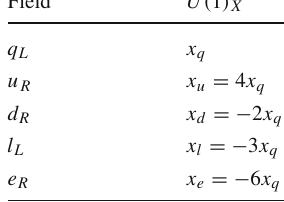
fermions charges under U ( 1 ) X to guarantee the anomaly cancellation